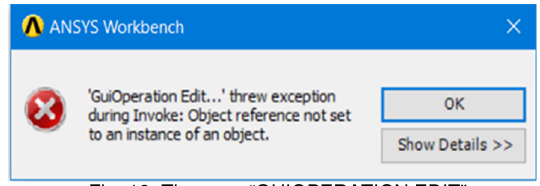
Fig. 18: The error “GUIOPERATION